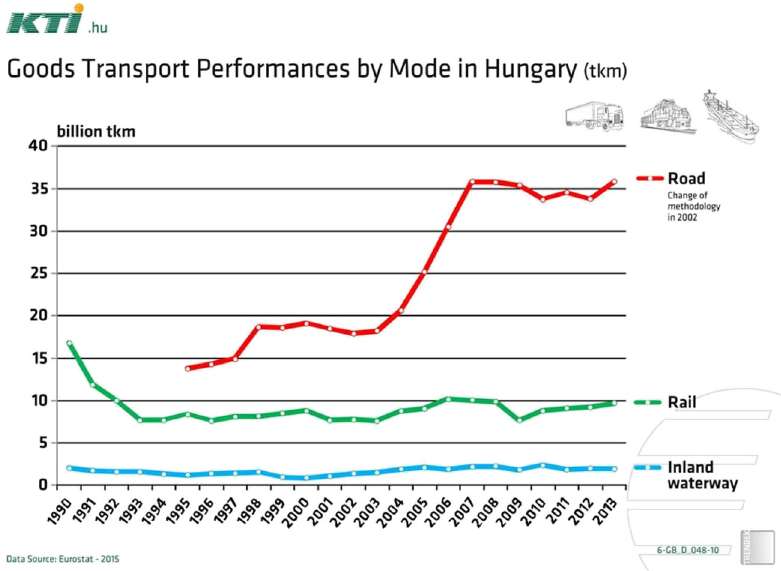
Fig. 1 Freight modal split in Hungary between 1970 and